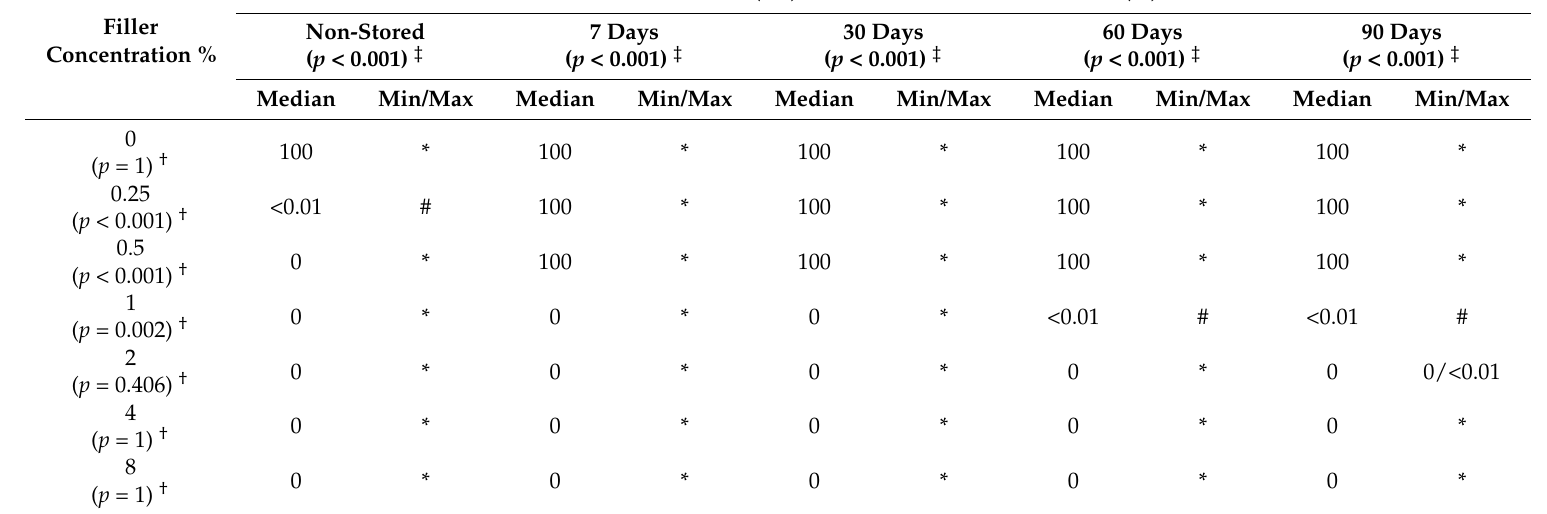
p -values marked † : refer to the SR differences listed in rows (different storage durations for a particular material); and those marked ‡ : refer to SR differences listed in columns; *: no changes in quadruplicate; #: both below 0.01 but more than